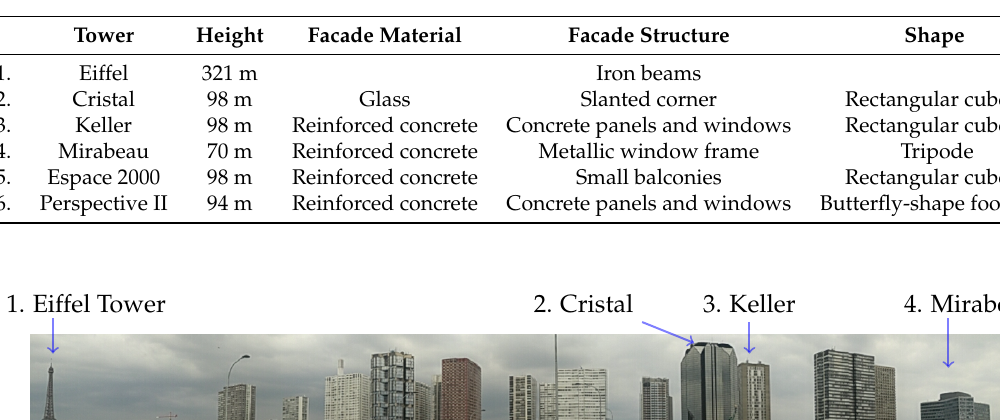
Table 2. Characteristics of the six studied buildings.